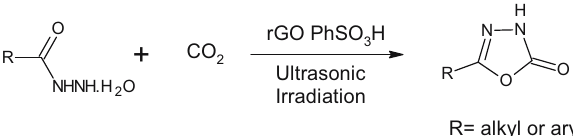
Scheme 10: Direct synthesis of 1,3,4 - oxadiazoles from hydrazides using rGOPhSO 3 H catalyst.